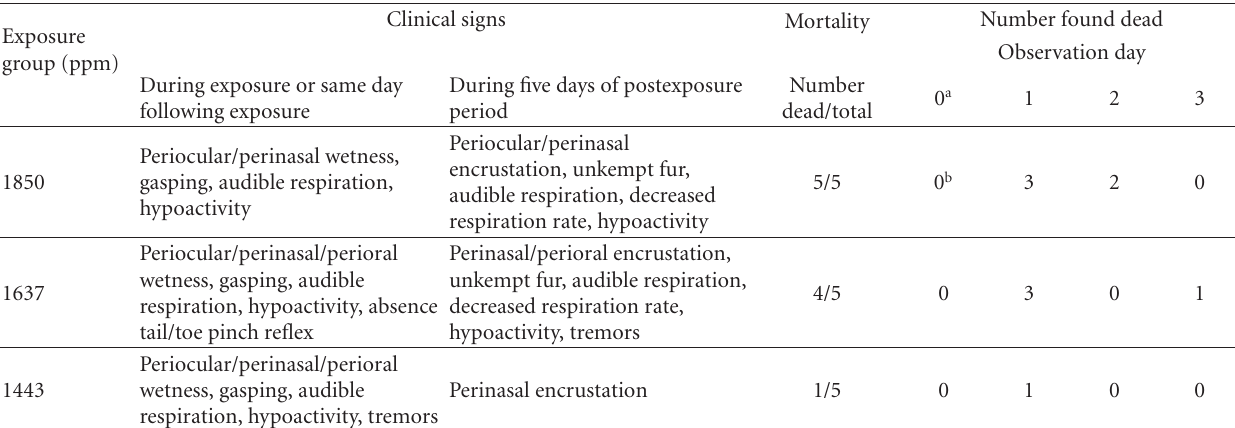
Table 2: Clinical observations, mortality rates, and day of death for female rats following 4-hour exposure to EO.